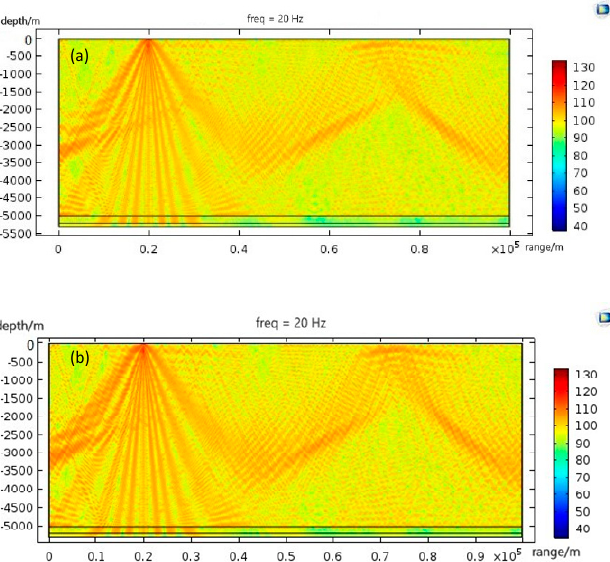
Figure 10. Distribution of sound pressure levels (dB) under different intensities of warm vortices, ( a ) DC = 20 m/s and ( b ) DC = 10 m/s. ( a ) DC = 20 m/s and ( b ) DC = 10